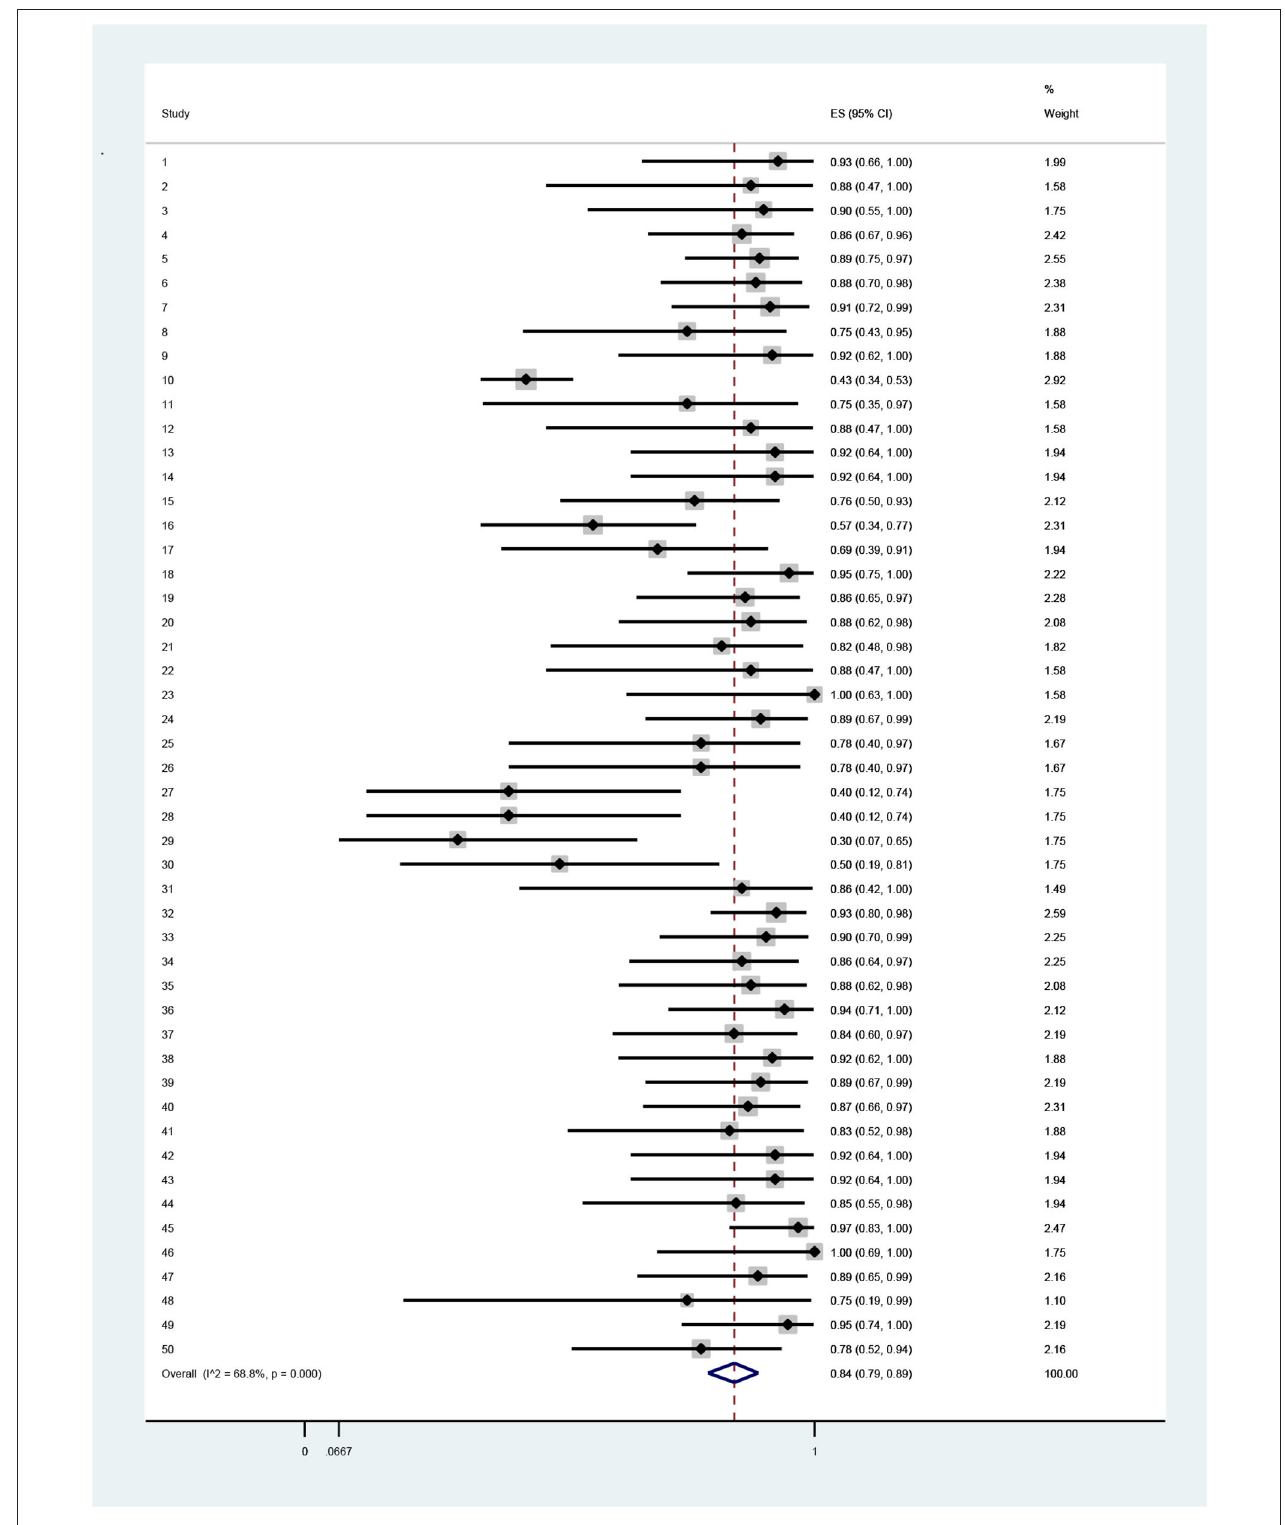
FIGURE 2 | Forest plot of estimates and 95% confidence intervals of the technical efficiency among Iranian hospitals.